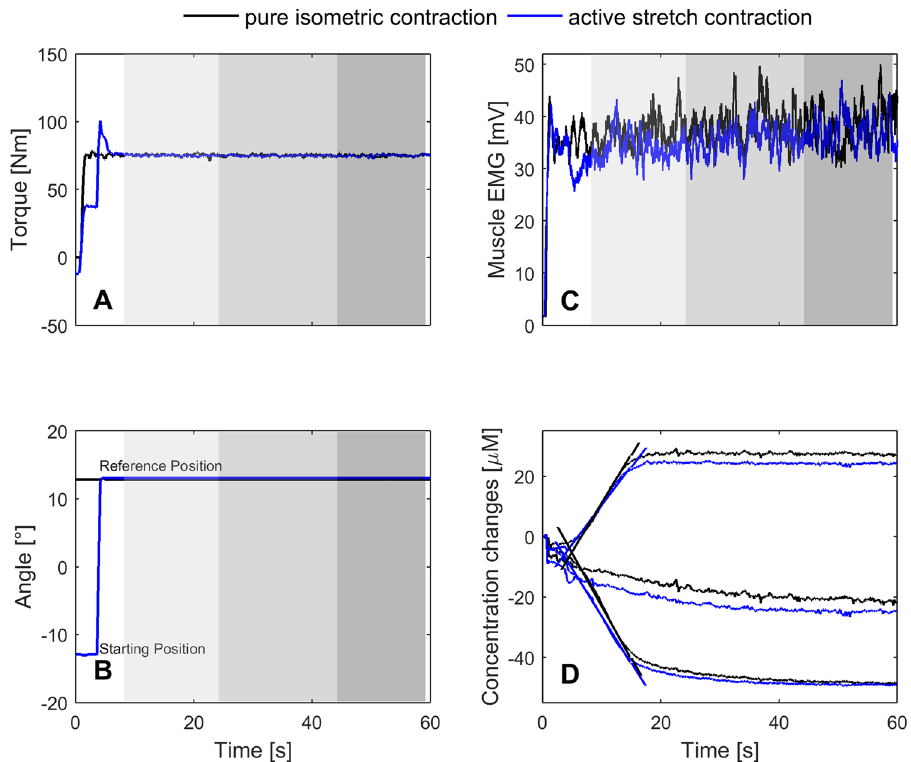
Figure 3. Exemplar data of measured parameters during an active stretch contraction (blue) and a pure isometric contraction (black). Different background colours in ( A – C ) represent three analysed time windows (Light grey: 4–20 s. Grey: 20–40 s. Dark grey: 40–55 s). A: Plantar flexion torque. B: Ankle angle. C: Muscle EMG of gastrocnemius medialis. ( D ) Near-infrared spectroscopy data. Upper-two lines represent deoxygenated haemoglobin. Mid-two lines represent total haemoglobin. Lower-two lines represent oxygenated haemoglobin. For these data the mean out of the slopes from the oxy- and deoxygenated haemoglobin of the two contraction conditions was calculated as representative of muscle oxygen consumption. Note: The time references in ( A – C ) are the same for both contraction